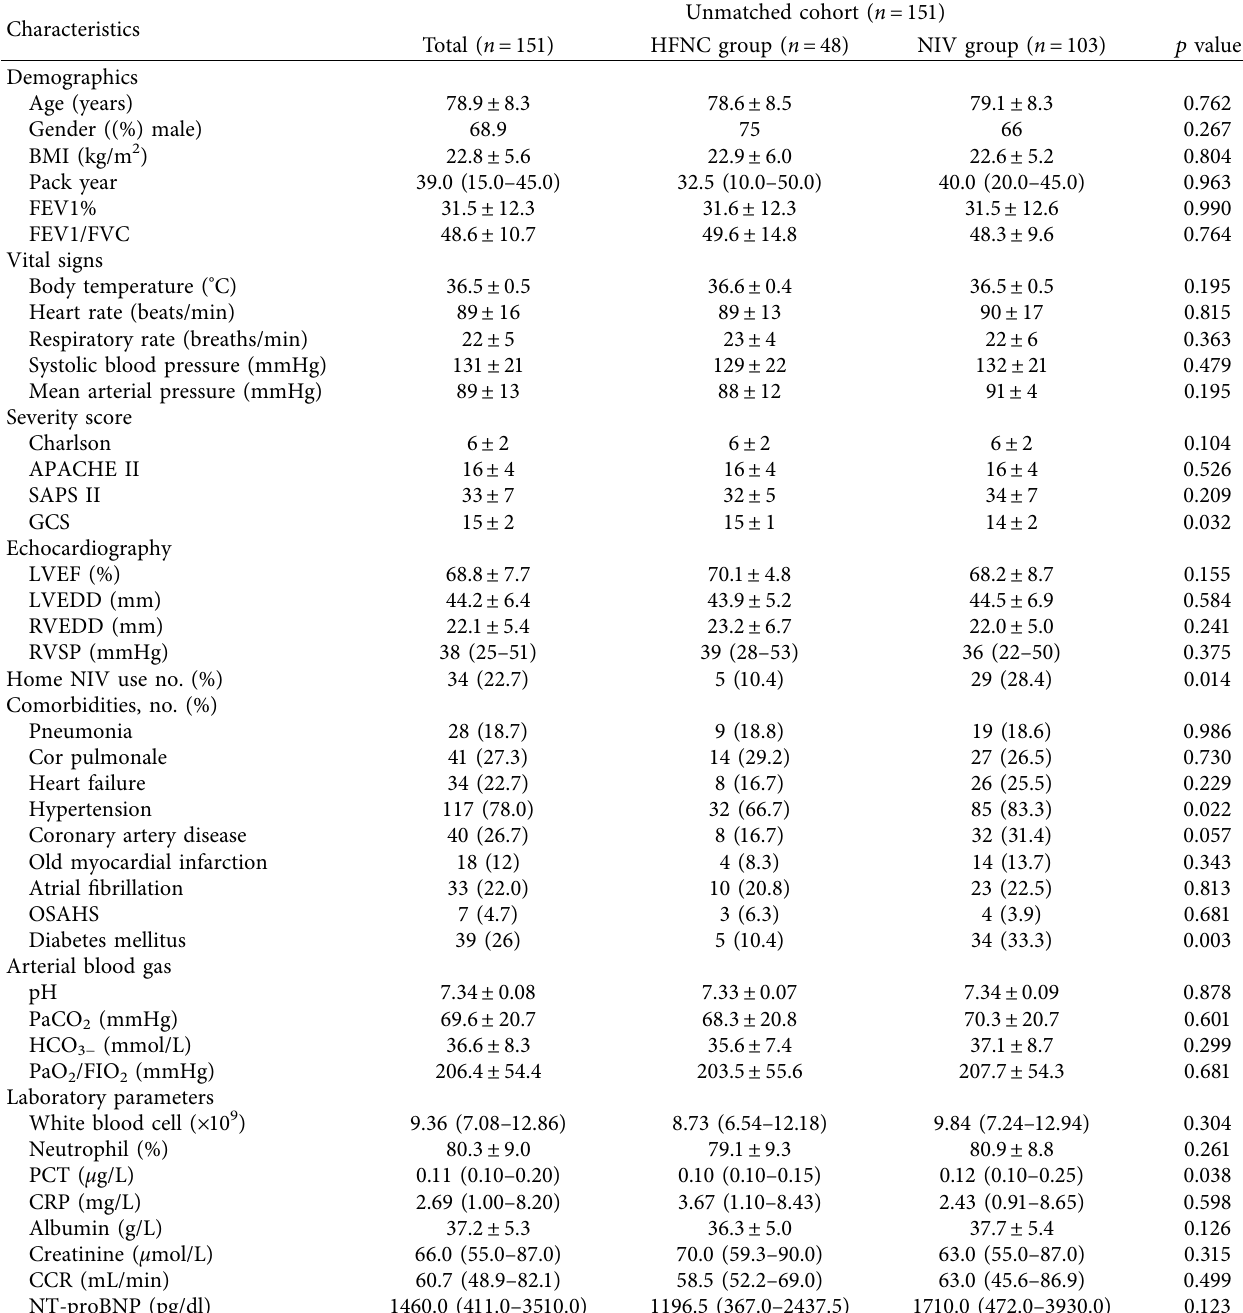
Table 1: Baseline characteristics at the time of ICU admission before propensity score